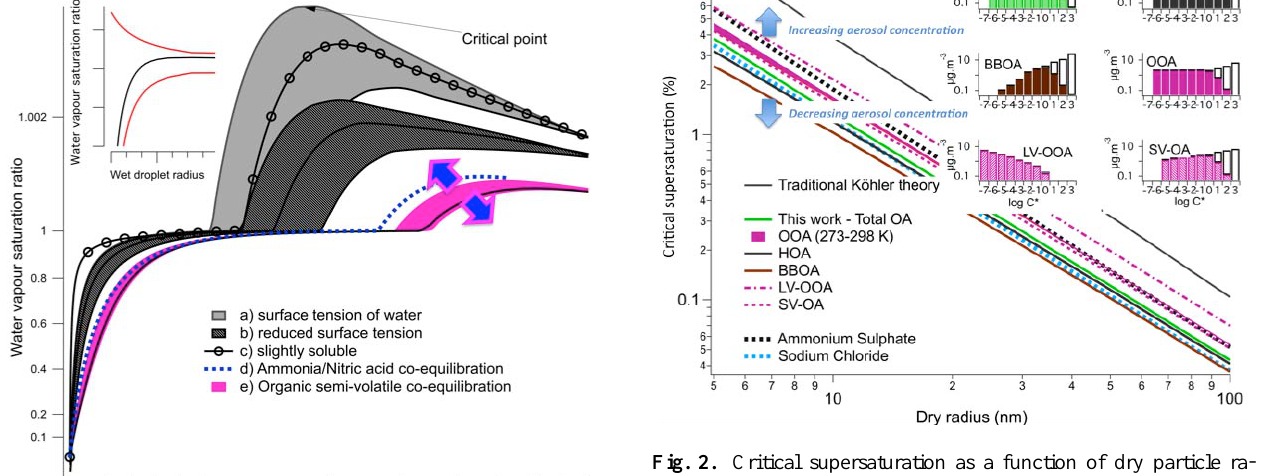
Fig. 2. Critical supersaturation as a function of dry particle ra- dius (nm) for multiple semi-volatile fractions taken from Cappa and Jimenez (2010), shown in the inset panel. “Total OA” repre- sents the entire semi-volatile fraction, the “Traditional K¨ohler the- ory” lines representing traditional K¨ohler theory predictions for the same aerosol type. Additional representations are as follows: HOA- Hydrocarbon-like, OOA – Oxygenated, BBOA-Biomass burning, LV-OOA – Low volatility, SV-OOA – Semi-volatile organic aerosol. For reference the S crit for NaCl, ( NH 4 ) 2 SO 4 are given as blue and black dashed lines. The actual amount of soluble material condens- ing per particle will depend on the size distribution and number concentration. To demonstrate this, the solid blue arrows arrows indicate the direction the predicted critical saturation ratios, after accounting for co-condensation, would follow on increasing and de- creasing the concentration of particles. The shape of the size distri- bution, concentration, volatility profile and amount of condensable material will dictate this final result, a solution of the condensation dynamics the focus of future